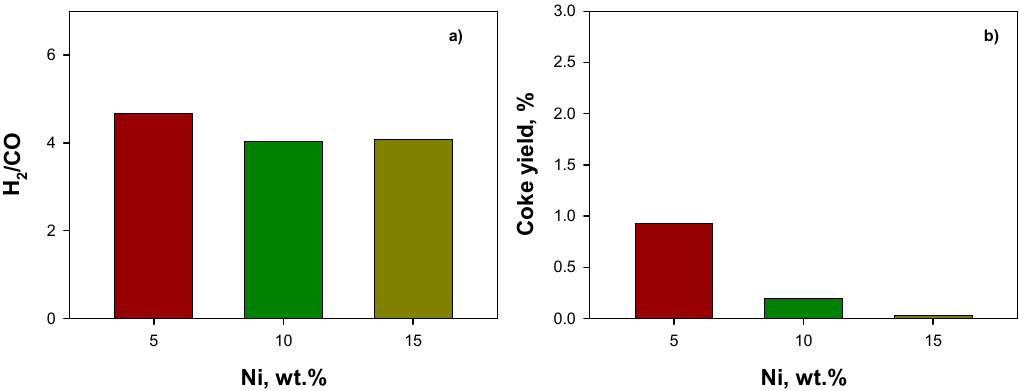
Figure 7. ( a ) H 2 /CO ratio for 5 Ni, 10 Ni, and 15 Ni monoliths during steam reforming of HB mixture at 720 °C and atmospheric pressure; gas-phase feed composition: Solvent/H 2 O/O 2 /N 2 = 0.7/6/0.8/92.5. ( b ) Coke yields for 5 Ni, 10 Ni, and 15 Ni monoliths.